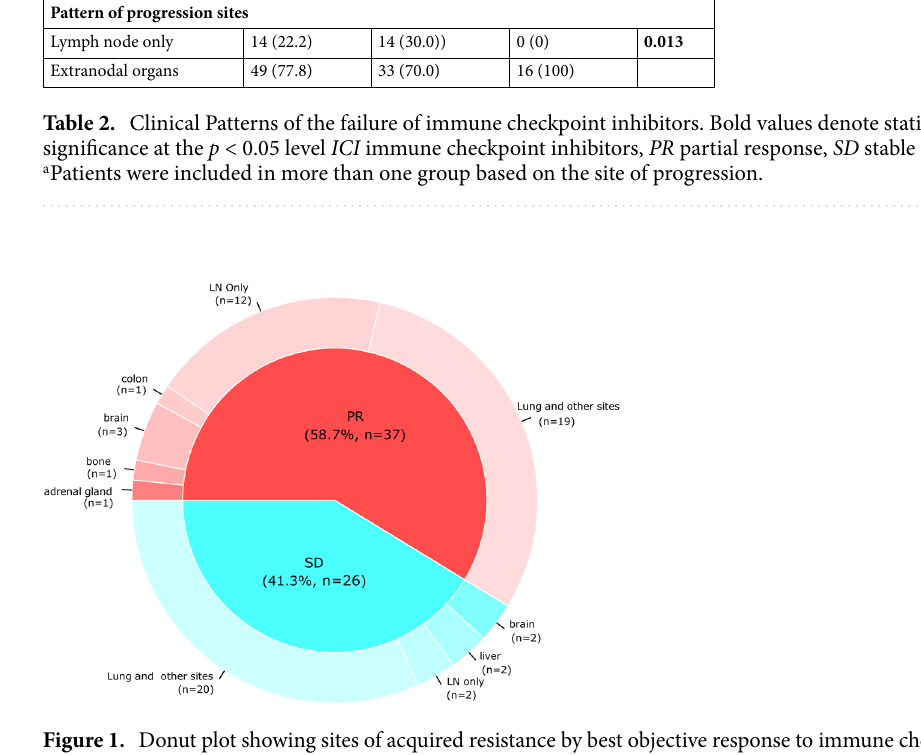
Figure 1. Donut plot showing sites of acquired resistance by best objective response to immune checkpoint inhibitors. LN lymph node, PR partial response, SD stable